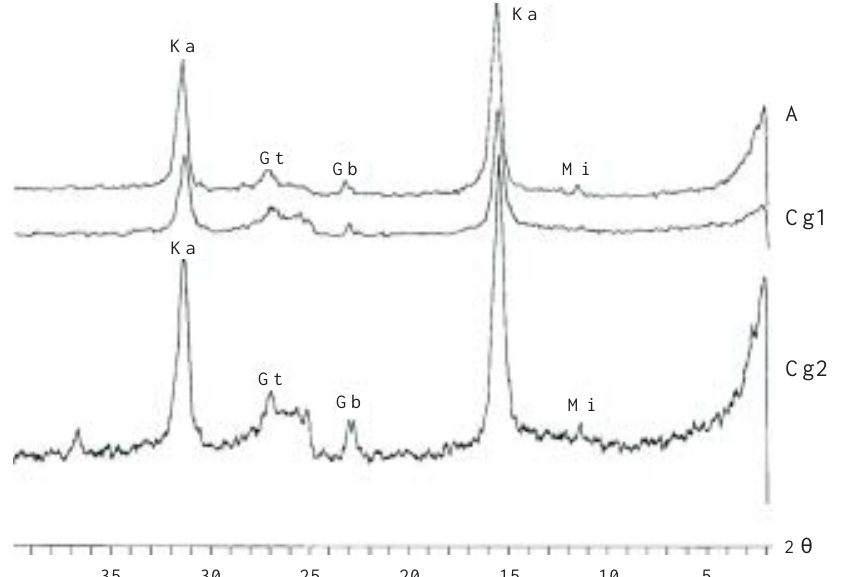
Figura 2. Difratogramas de raios X da fração argila dos diferentes horizontes do Perfil 2 – Gleissolo Melânico distrófico típico (Ka – caulinita, Gt – goethita, Gb – gibbsita, Mi –